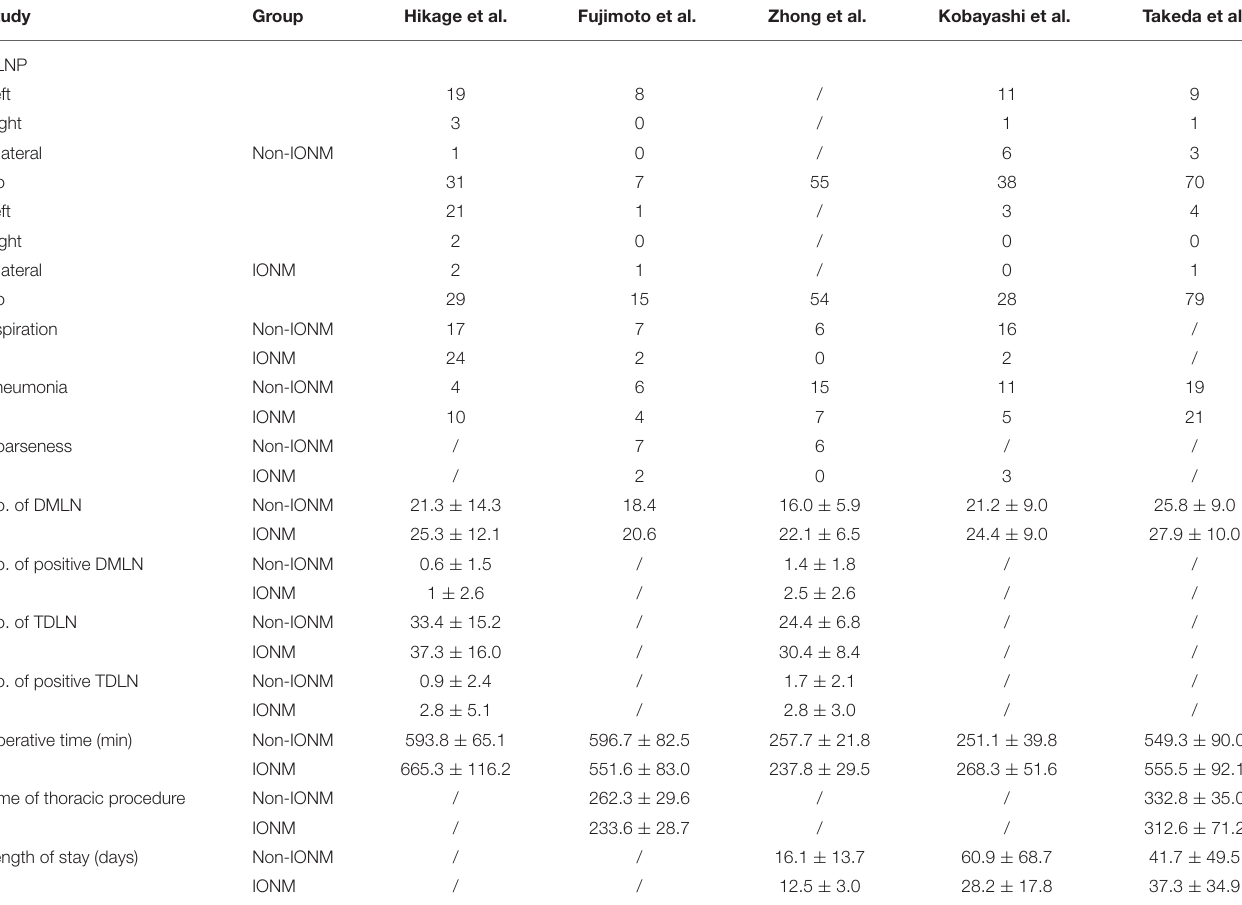
TABLE 3 | Surgical outcomes.